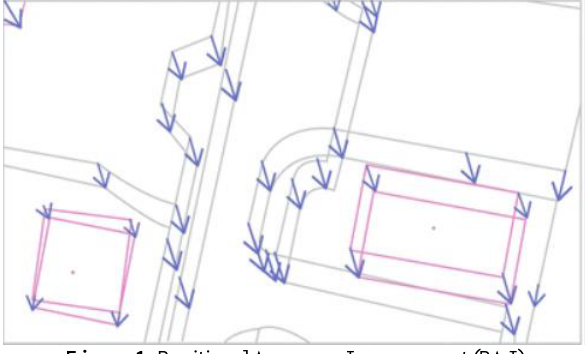
Figure 1. Positional Accuracy Improvement